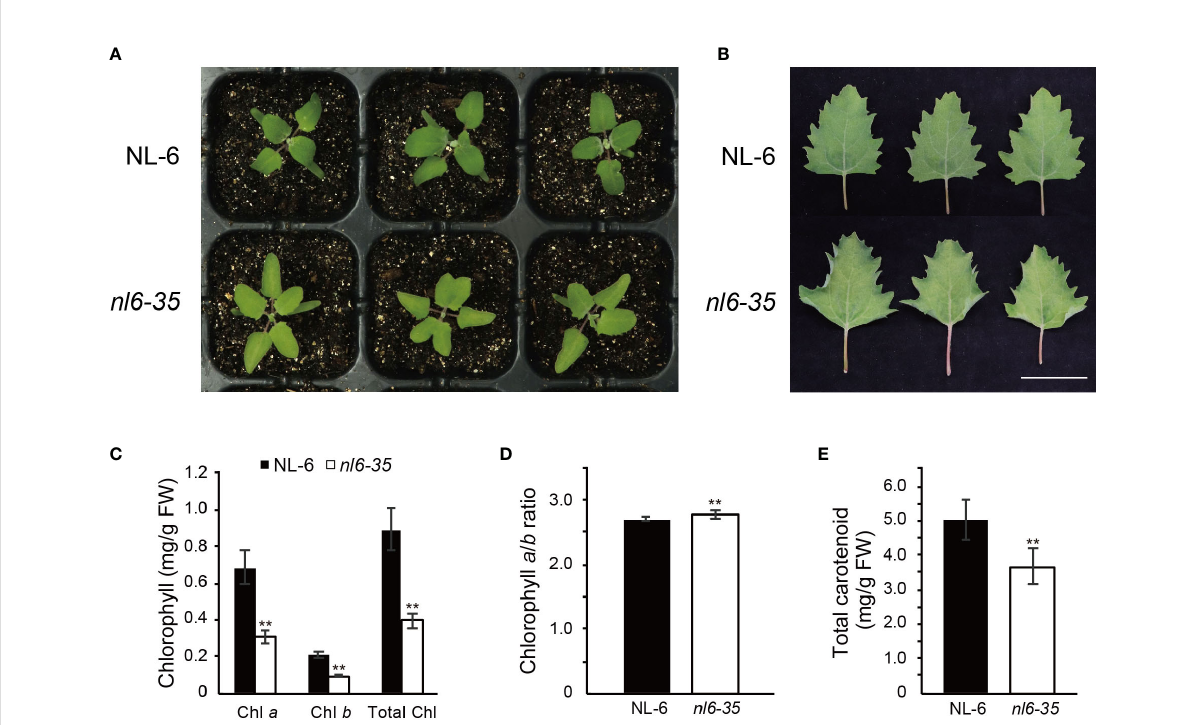
FIGURE 1 Identi fi cation of quinoa mutant nl6-35 that exhibits faded green leaf and reduced Chl. (A) Phenotype of wild type (NL-6) and nl6-35 plants grown on soils for 14 days under a light cycle of 12 h light/12 h dark. (B) Phenotype of the leaves of 30-day-old plants grown under a light cycle of 12 h light/12 h dark. Scale bar, 5 cm. (C) Measurement of Chl a , Chl b , and total Chl in wild type (NL-6) and nl6-35 plants. Values are the means ± SD of six biological replicates. Asterisks indicate statistically signi fi cant differences (**p < 0.01, Student ’ s t -test). (D) The ratio of Chl a / Chl b in wild type (NL-6) and nl6-35 plants. Values are the means ± SD of six biological replicates. Asterisks indicate statistically signi fi cant differences (**p < 0.01, Student ’ s t -test). (E) Quanti fi cation of total carotenoid content in each genotype. Values are the means ± SD of six biological replicates. Asterisks indicate statistically signi fi cant differences (**p < 0.01, Student ’ s t